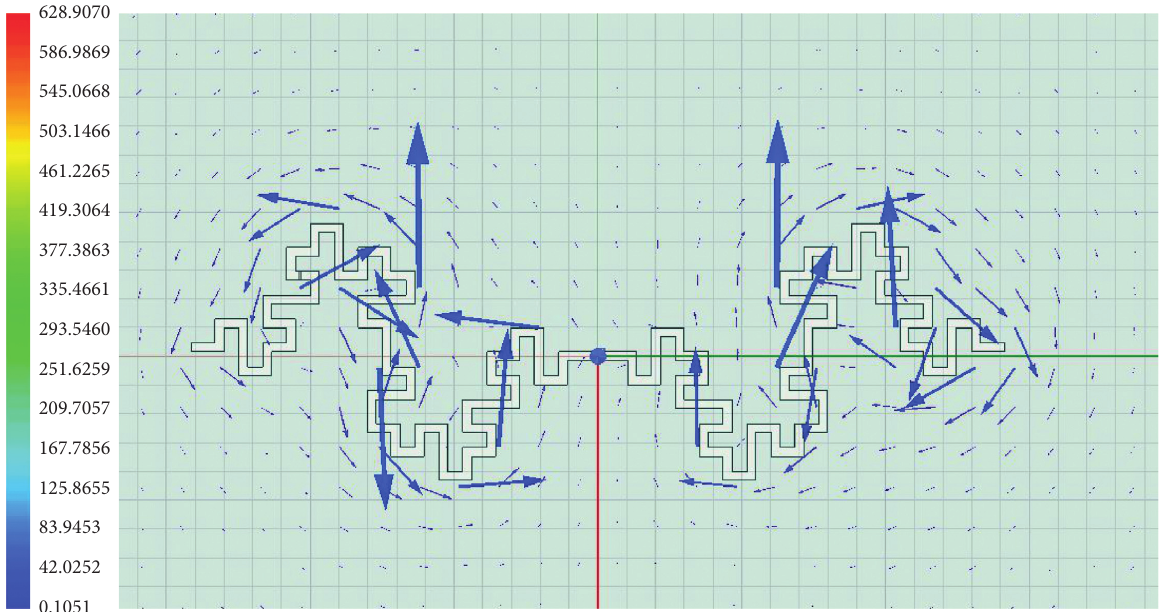
Figure 8: Simulated surface electric current distribution at phase angle ω t � 0 °